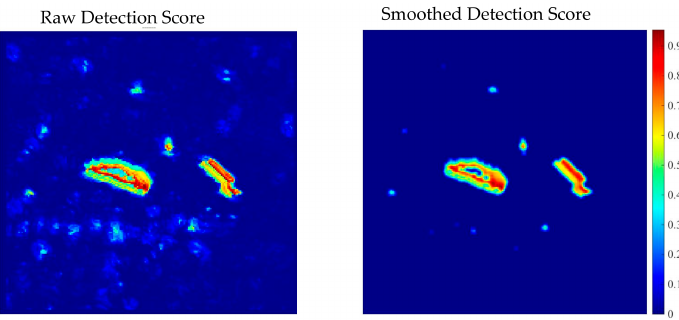
Figure 6. The target detection score by the traditional DM